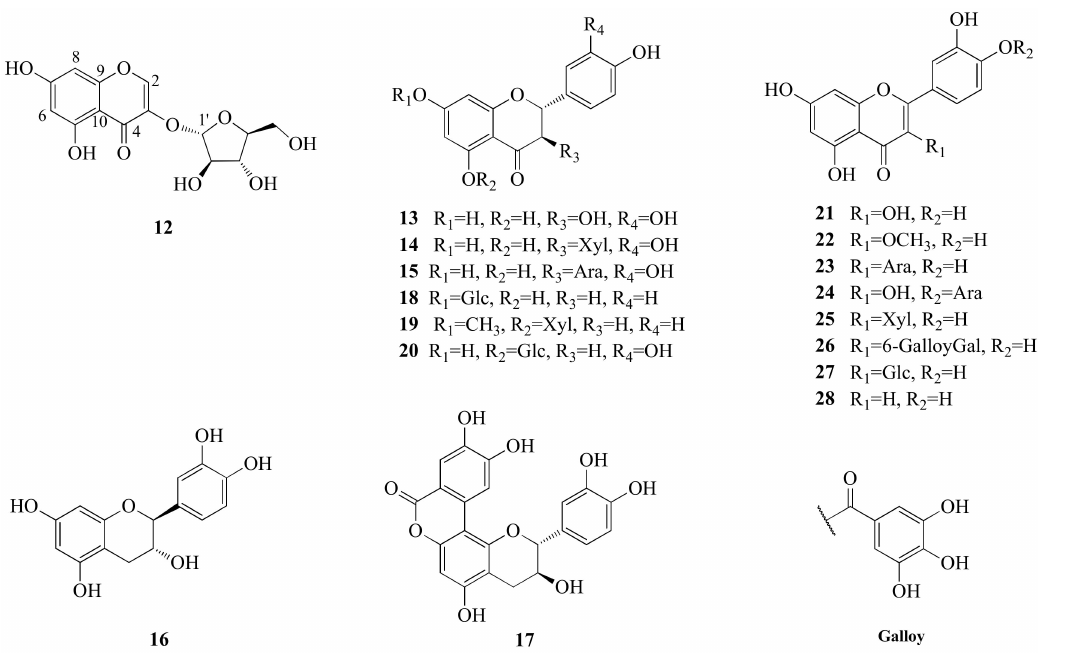
Figure 5. The structures of flavonoids ( 12 – 28 ) isolated from Diaphragma juglandis Fructus. (Ara = α - L -arabinofuranose; Xyl = β - D -xylopyranose; Glc = β - D -glucopyranose; Gal = β - D - galactopyranose).